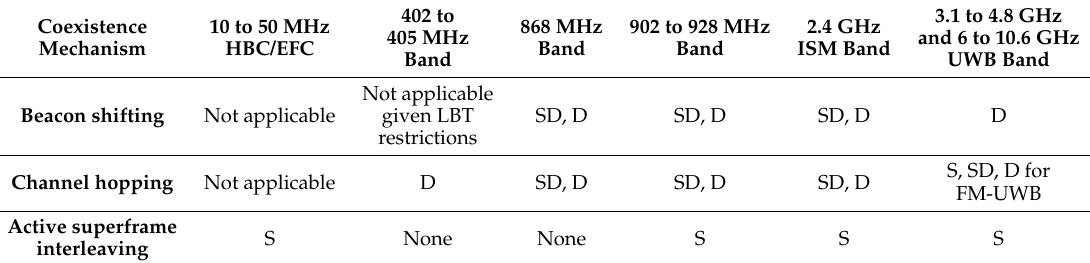
Table 2. Recommended coexistence